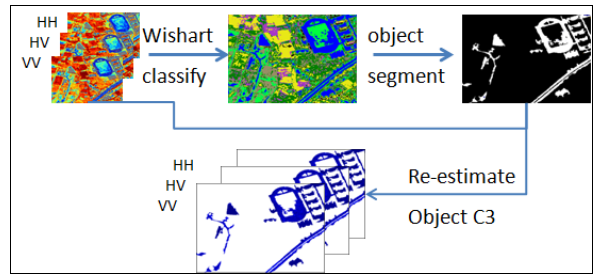
Figure 5. The flow chart of the refined C3 matrix by OBE